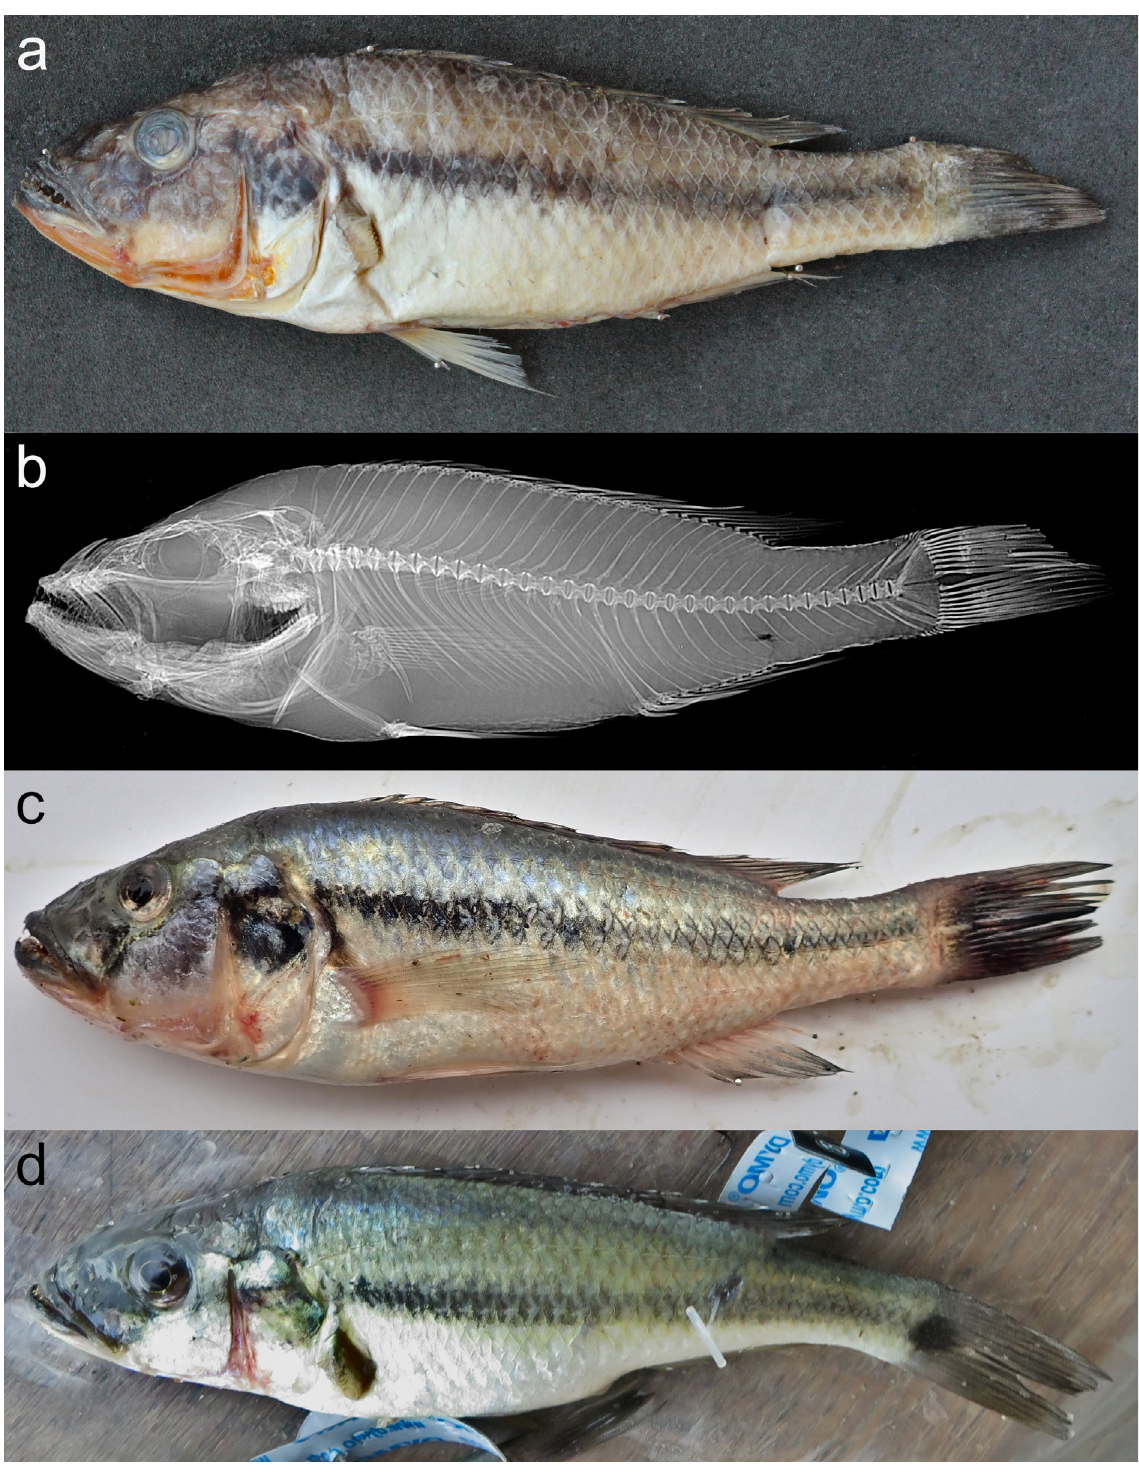
Fig. 6. Haplochromis latifrons sp. nov. a . Photograph of preserved holotype (RMCA 2018.008.P.0330; 158.2 mm SL). b . X-ray image of holotype. c – d . Photographs of freshly caught specimens. c . Holotype. d . Another female (RMCA 2017.006.P.0340; 105.4 mm SL) to illustrate the live colour patterns. The contrast was slightly